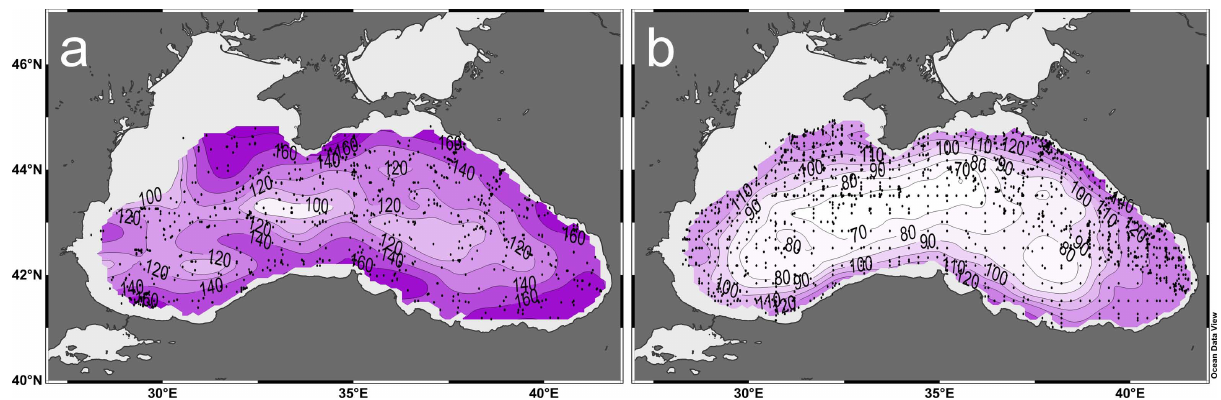
Fig. 13. The mean depth of the upper boundary of the suboxic zone (UBSOZ) in the Black Sea for the periods 1955–1976 ( a ) and 1987–2011 ( b